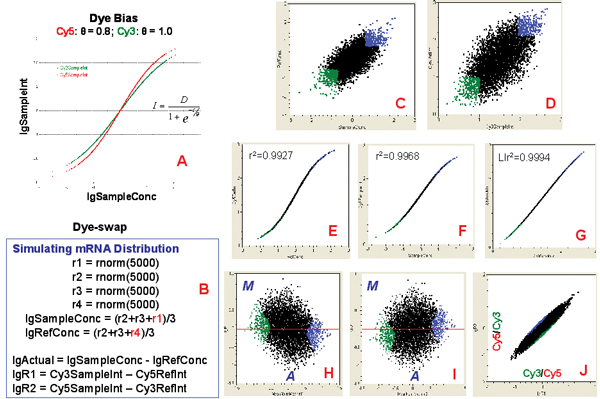
Simulation of the characteristics of dye-swap replicates. A: Dye bias is simulated by a difference in θ of the Sigmoid function; B: Dye-swap pairing; C: log mRNA concentrations for the two samples ("Sample" and "Ref"); D: Scatter plot of log intensities for one replicate of the dye-swap pair; E: Calibration curve for Cy5 ("labeled" with "Ref"); F: Calibration curve for Cy3 ("labeled" with "Sample"); G: log intensity correlation for the same sample ("Sample") labeled with two dyes in the dye-swap pair; H: MA plot for "Ref" labeled with Cy5 and "Sample" labeled with Cy3; I: MA plot for "Ref" labeled with Cy3 and "Sample" labeled with Cy5; J: log ratio correlation of the dye-swap pair. Spots colored in green are of lower average intensity, whereas spots colored in blue are of higher average intensity.